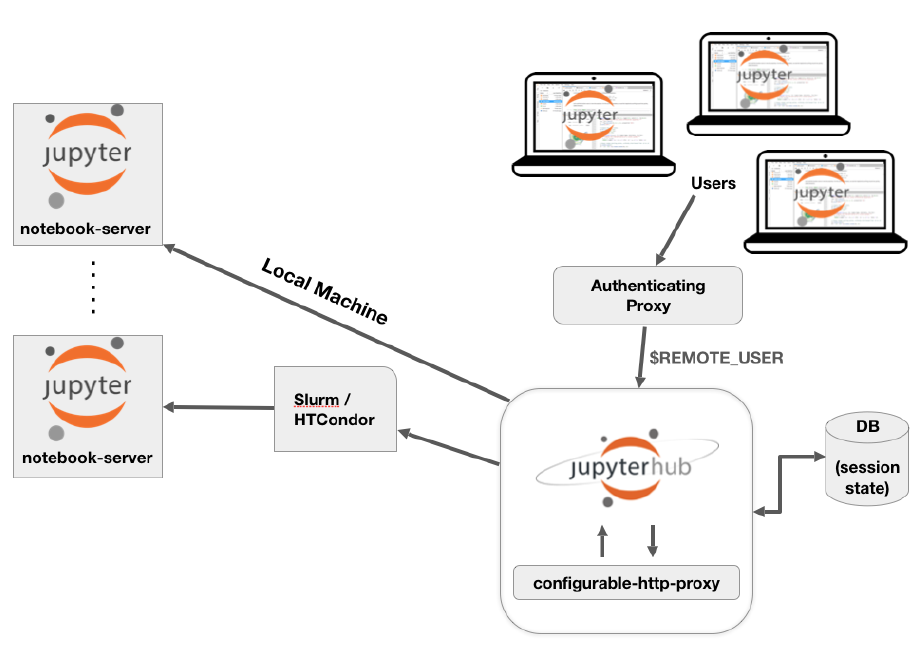
Figure 1. Schematic diagram of the Jupyterhub-based SDCC analysis portal